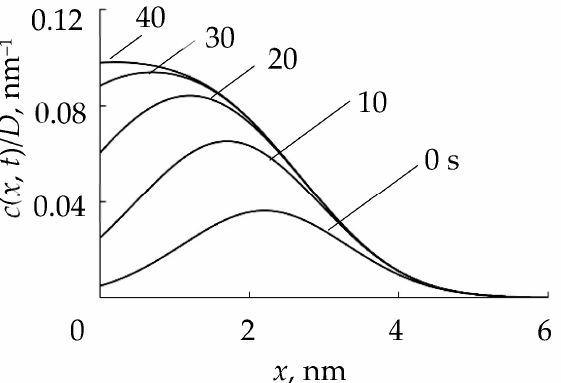
Figure 16. Distribution of the relative concentration of implanted ions N + 0.45 keV and different points in time.